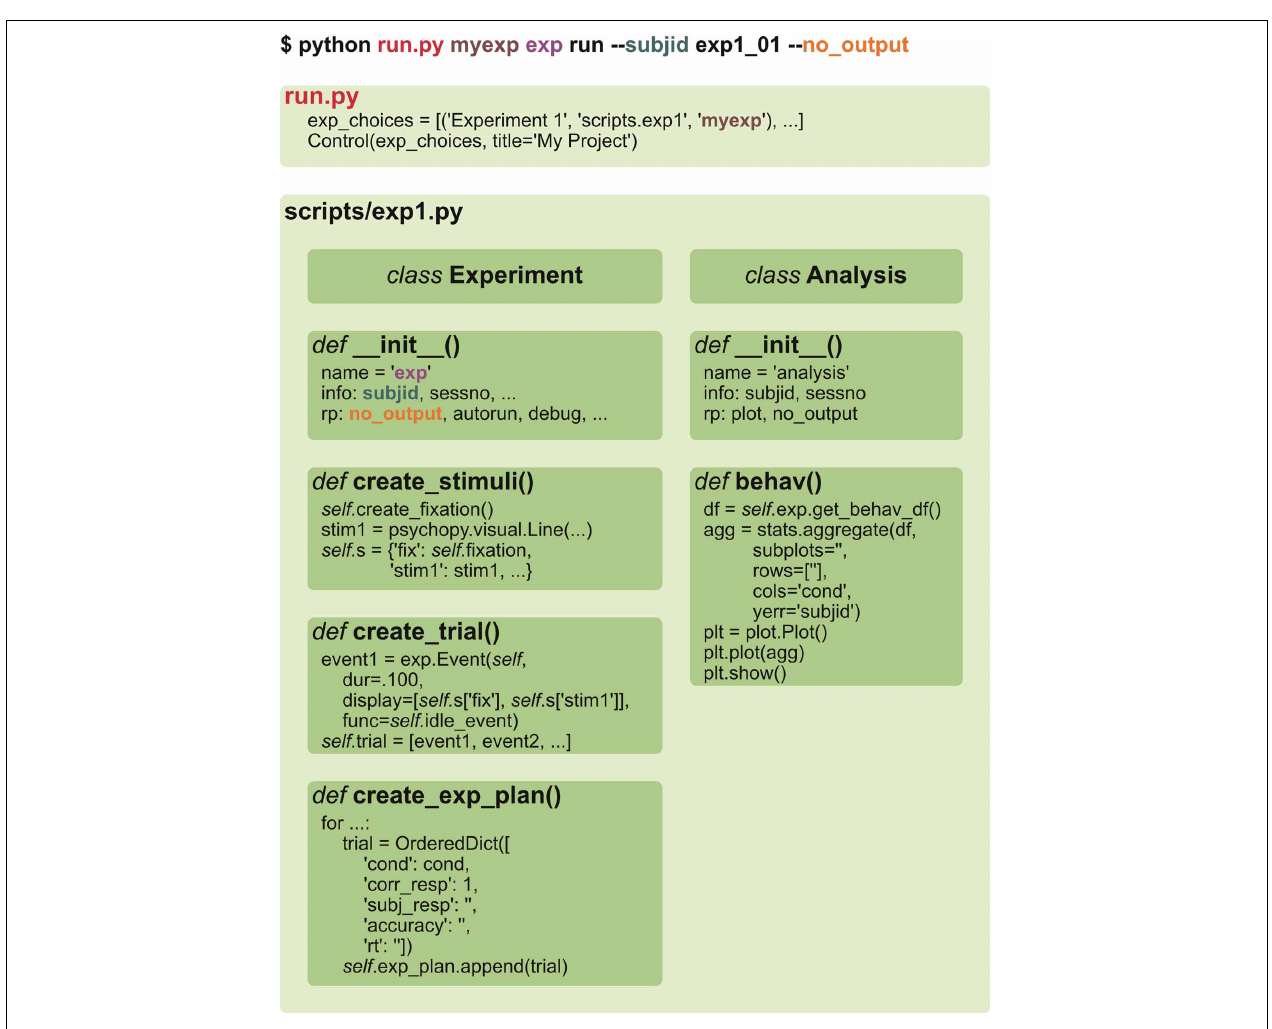
FIGURE 5 | A typical experiment and analysis structure. A user executes run.py file either without any arguments (resulting in a GUI) or with them (as shown in this example). Then, relevant scripts (brown), classes (purple) and